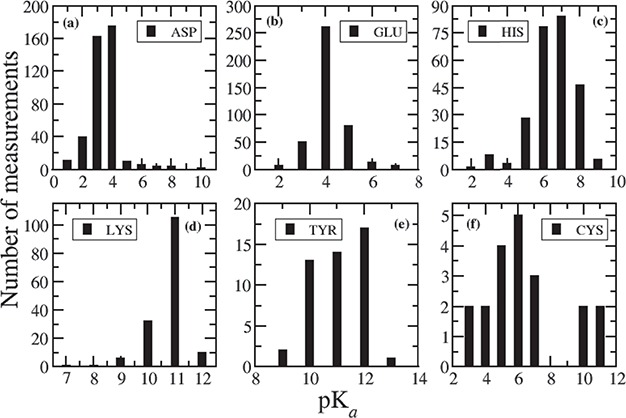
Distribution of measured pKa values for (a) ASP, (b) GLU, (c) HIS, (d) LYS, (e) TYR and (f) CYS.